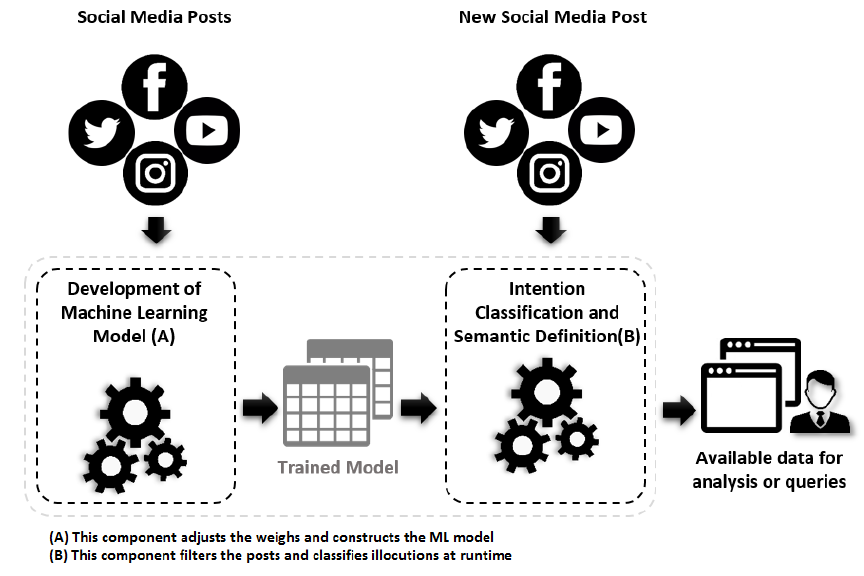
Figure 2. Overview of the